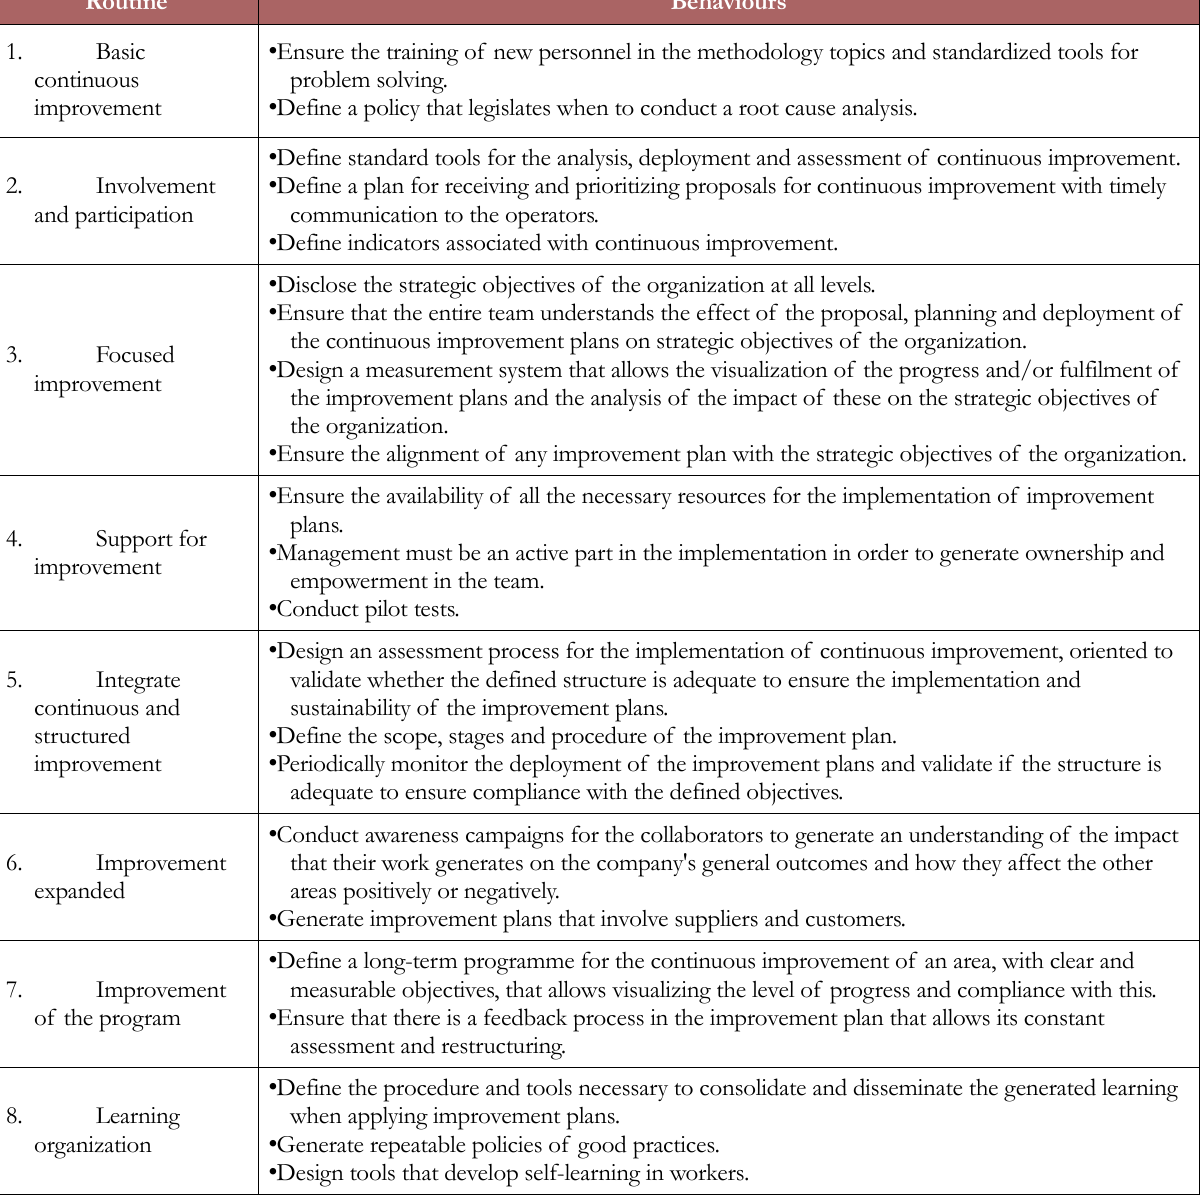
Table 5. Key lessons learned and behaviours to promote the maturity of continuous